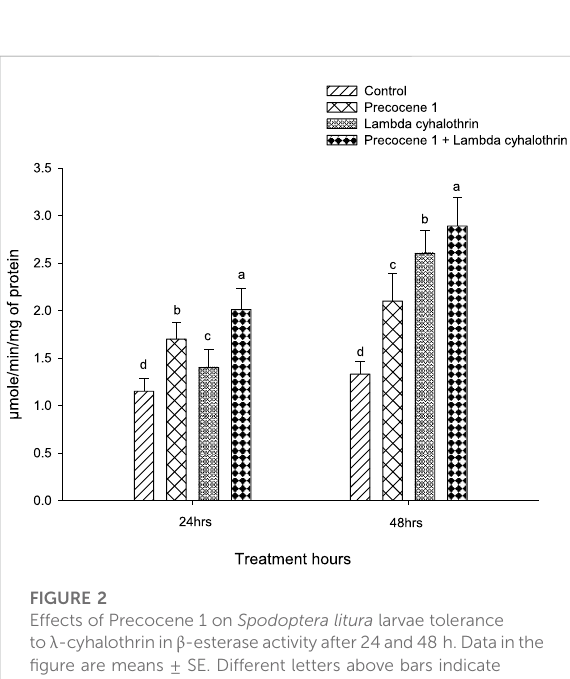
FIGURE 3 Effects of Precocene 1 on Spodoptera litura larvae tolerance to λ -cyhalothrin in glutathione-S-transferase activity after 24 and 48 h.Datainthe fi gurearemeans±SE.Differentlettersabovebars indicate signi fi cant differences ( p < 0.05) according to the Tukey HSD test.